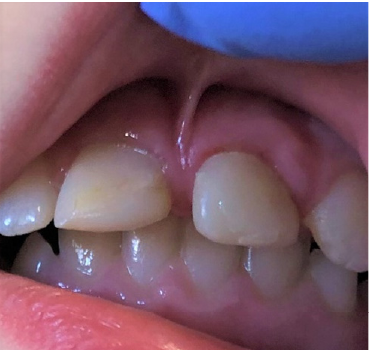
Figure 12. Overgrown, low, papilla penetrating attachment of the upper lip frenulum (type III acc. Placek) is causing a midline diastema in a school-age girl.